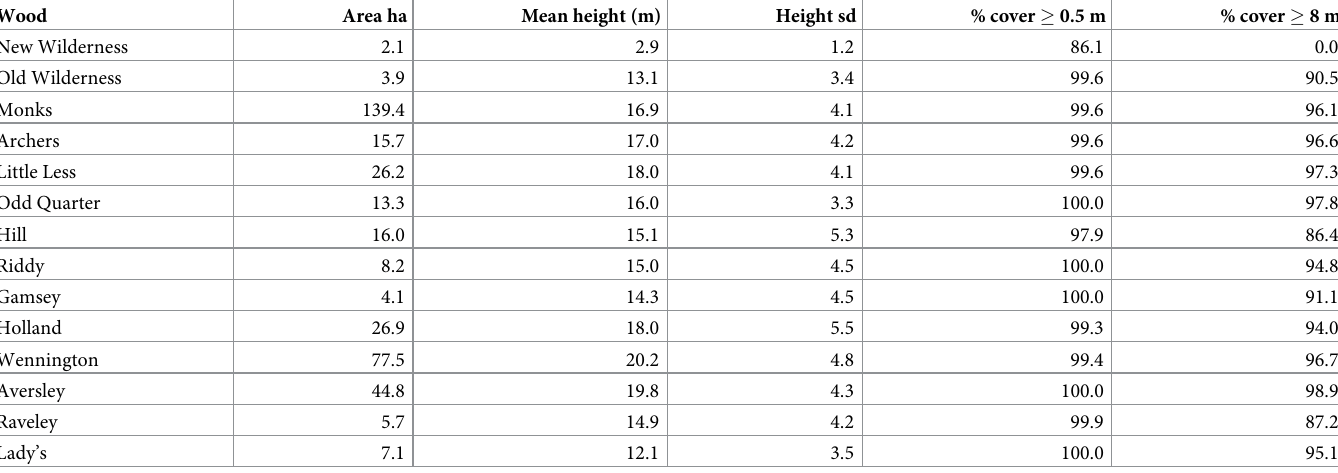
Table 2. Comparative tree canopy